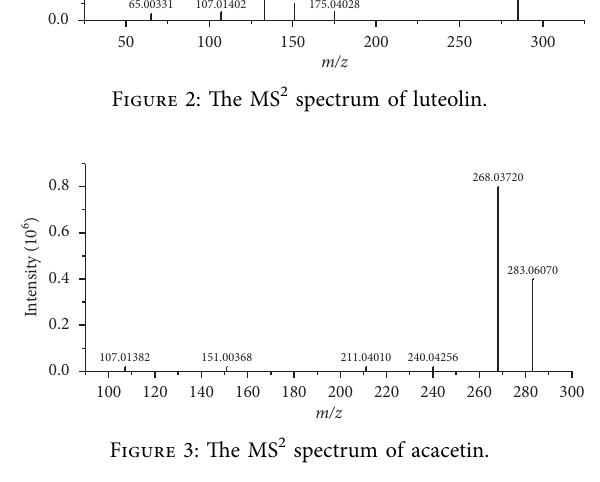
Figure 3: The MS 2 spectrum of